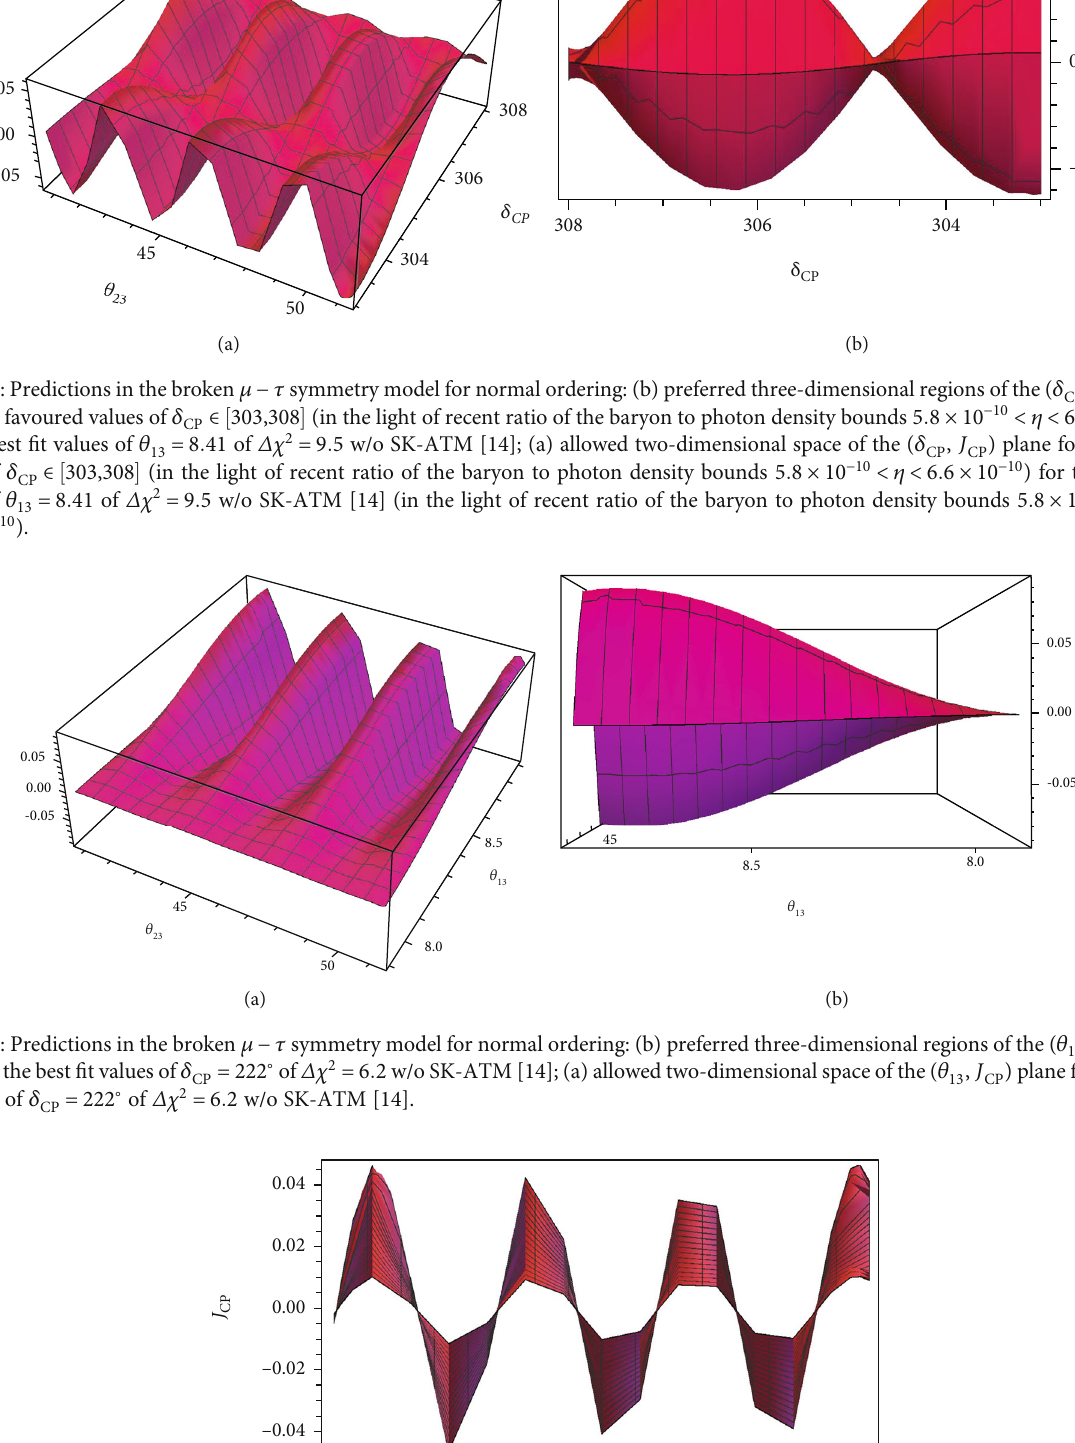
Figure 10: Predictions in the broken μ − τ symmetry model for normal ordering: variation of J normal ordering for tabulated Δχ 2 = 6 : 2 :